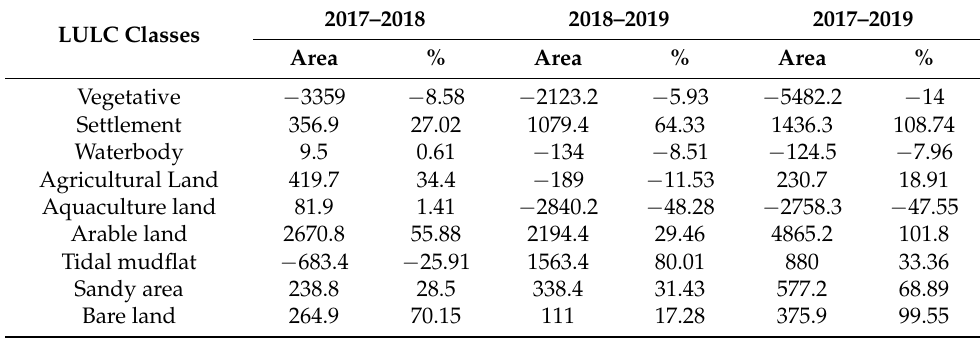
Table 4. Gain and loss of different LULC areas (in hectares and percentage) in Ukhiya-Teknaf, pre and post refugee crisis, by the period of observation.